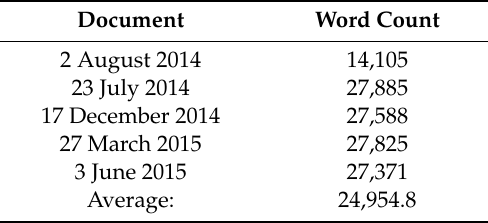
Table 2. Raw word count per